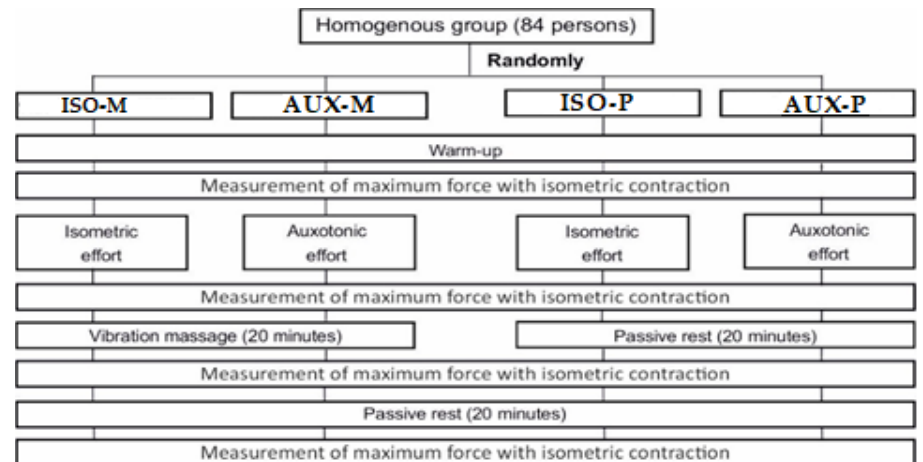
Figure 1. Experimental design.